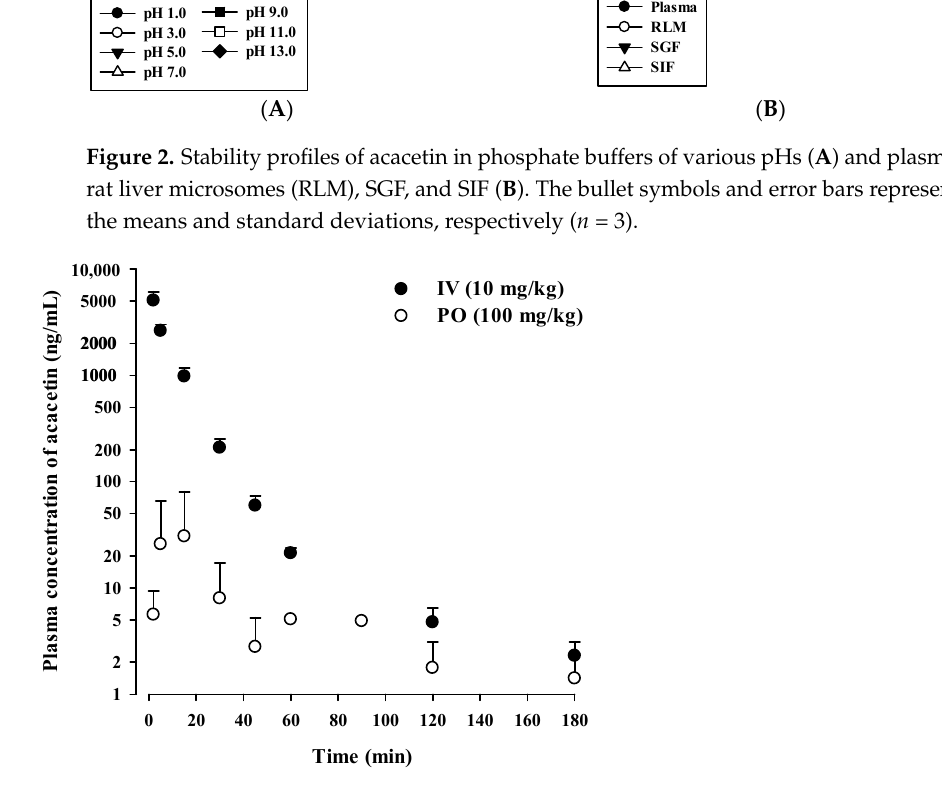
Figure 3. Plasma concentration versus time profiles of acacetin following intravenous administration at a dose of 10 mg/kg and oral administration at a dose 100 mg/kg in rats. The bullet symbols and error bars represent the means and standard deviations, respectively ( n = 3–4). Table 3. Pharmacokinetic parameters of acacetin following intravenous administration at a dose of 10 mg/kg and oral administration at a dose 100 mg/kg in rats ( n = 3–4).